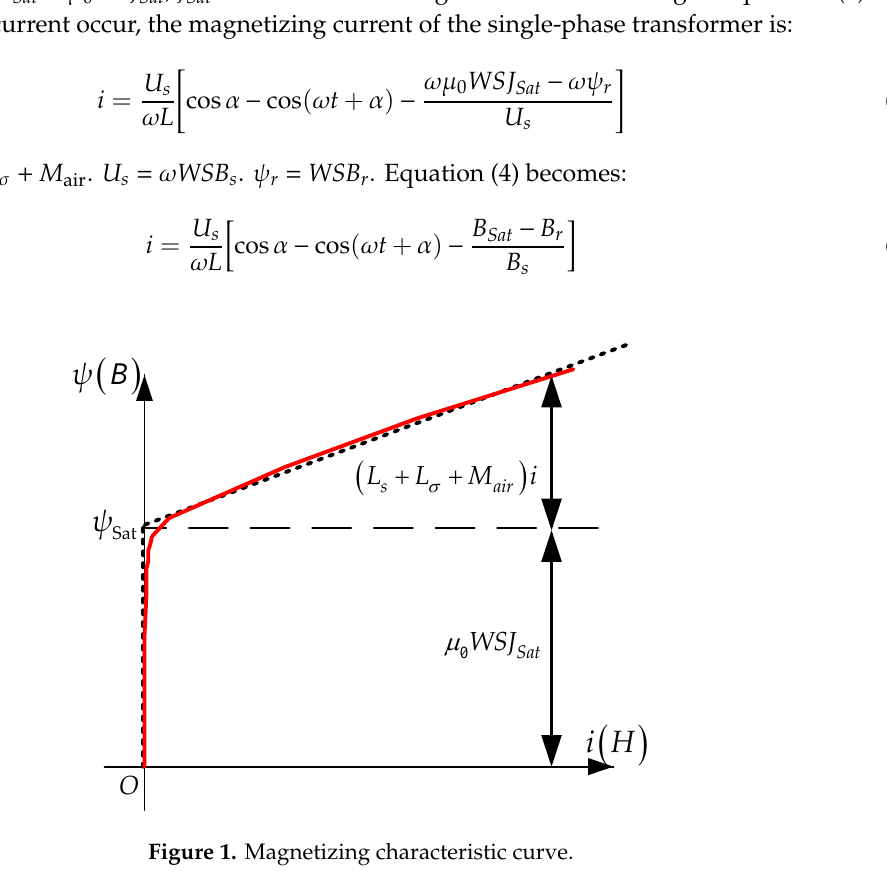
Figure 1. Magnetizing characteristic curve.